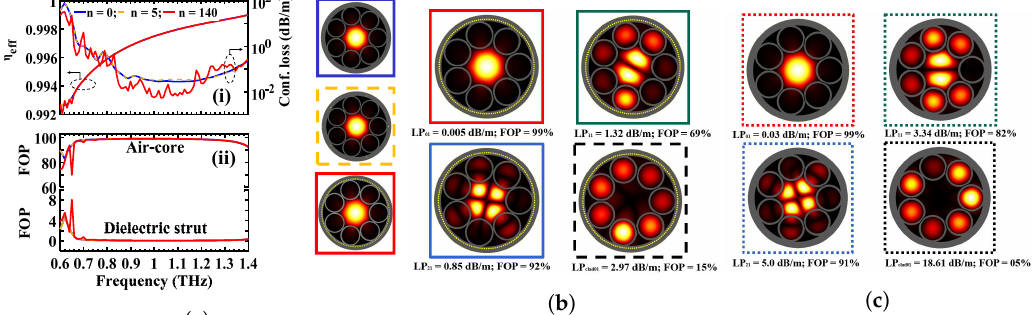
Figure 4. ( a ) Simulated (i) refractive index ( η eff ) in left axis and confinement loss of LP 01 -like fundamental mode in right axis; fraction of power in (ii) air core (FOP core ) at top and Zeonex strut (FOP strut ) at bottom. The simulations are performed by varying the metal wire numbers, n = 0, 5, and 140. The fiber has a uniform wire diameter d = 90 µ m and fixed dielectric thickness between the internal side of the metal wire and the inner dielectric cladding layer p = 289 µ m. Spatial electric field E distribution for the modes in the ( b ) AR fibers with metal-wire inclusions and ( c ) AR fibers without metal-wire inclusions: LP 01 , LP 11 , LP 21 , and LP clad01 (from left to right) at 1.03